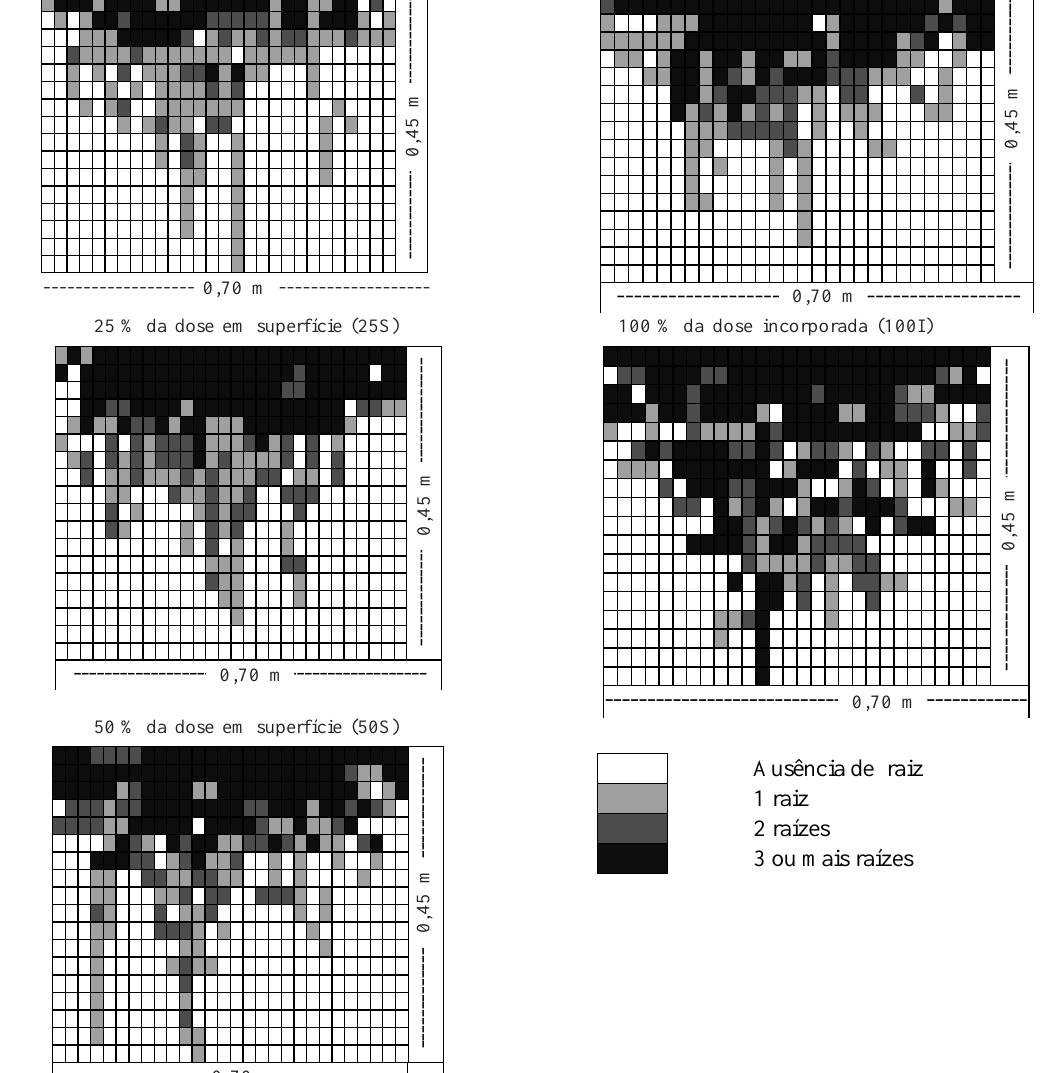
Figura 7. Perfil de enraizamento da cultura do milho aos 80 dias da emergência no Argissolo Vermelho distrófico arênico sob semeadura